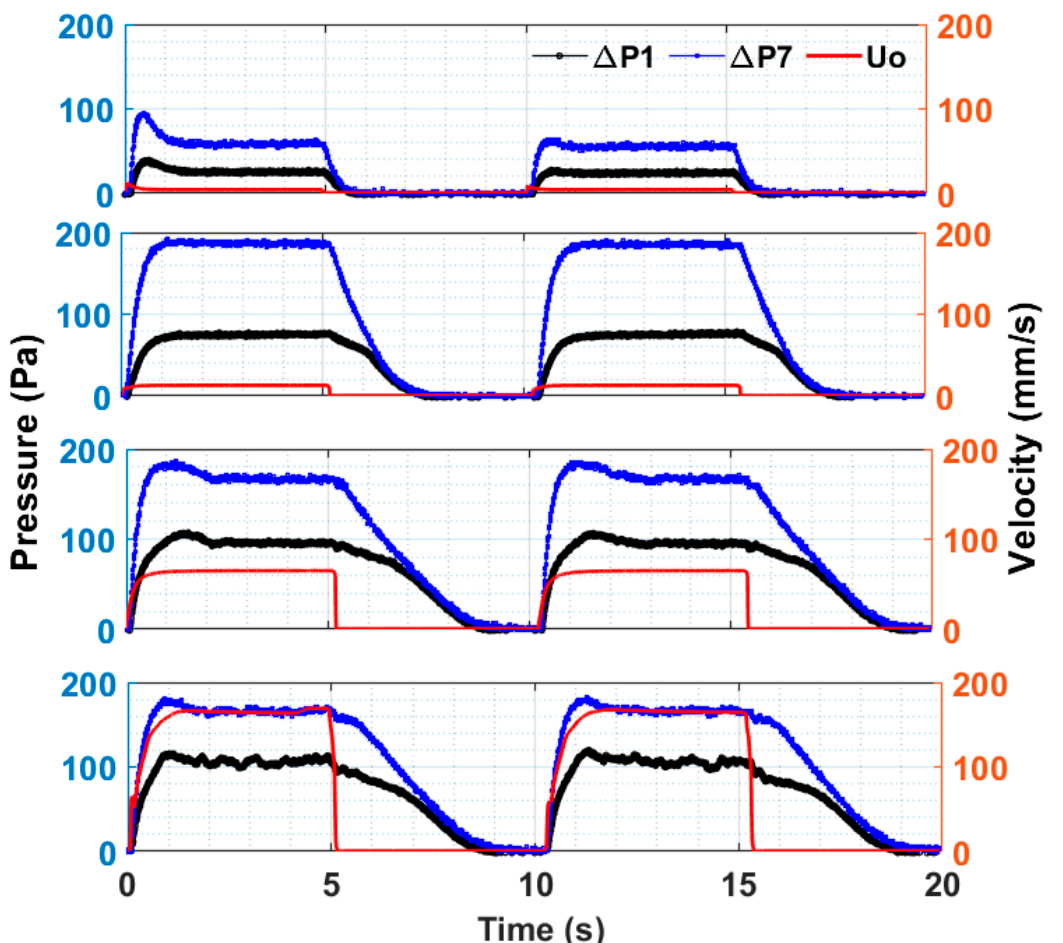
Figure 8. Overall ( ∆ P 7 ) and upper region ( ∆ P 1 ) pressure transients for U o = 4 mm / s, 12 mm / s, 65 mm / s, and 165 mm/s in pulsed fluidized beds.